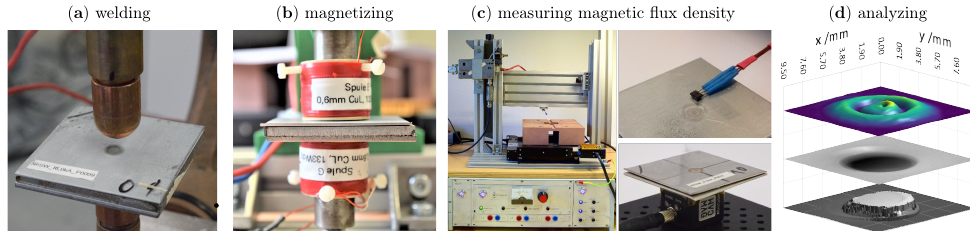
Figure 2. Test sequence for the passive magnetic flux density testing (pMFT) with ( a ) RSW-process, ( b ) magnetizing the spot weld with two coils oriented in the same direction, ( c ) measuring the residual magnetic flux density on the surface of the samples by scanning with one Hall-sensor (left and upper image) or by a Hall-sensor-array as a magnetic field camera MiniCube 1D provided by MAGCAM (lower image), and ( d ) analyzing the measured data with correlation to the nugget size of the spot